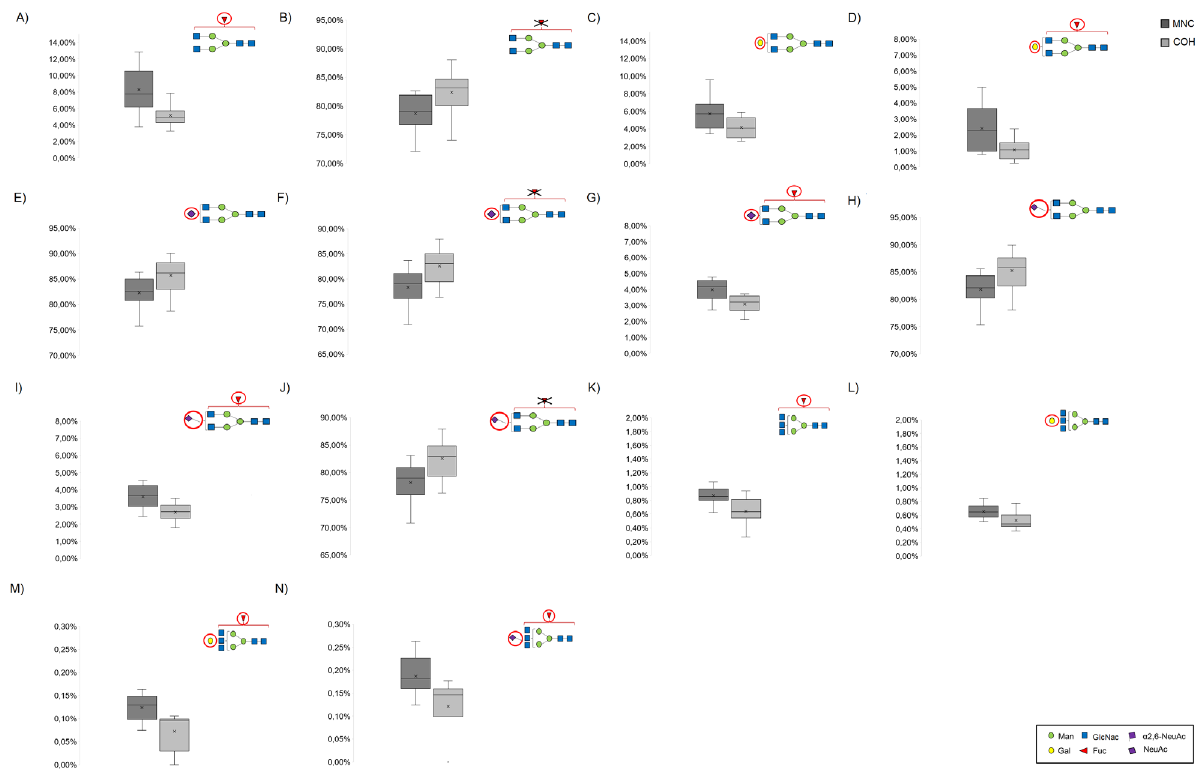
Figure 5: Statistically significant (Mann-Whitney U test, p<0,05) deregulated FFNGs-derived traits presented as mean ±SD between MNC and COH groups of patients. The presented traits are exclusively FFNGs additional traits derived from (A-J) diantennary and (K-N) triantennary complex type N-glycans identified in both analyzed groups. The displayed traits include: (A) % of fucosylated diantennary compositions; (B) % of afucosylated diantennary compositions; (C) % of galactosylation diantennary compositions; (D) % of galactosylation of fucosylated compositions; (E) % of sialylation of diantennary compositions; (F) % of sialylation of afucosylated diantennary compositions; (F) % of sialylation of afucosylated diantennary compositions; (G) % of sialylation of fucosylated diantennary compositions; (H) % of ɑ2,6- sialylation of diantennary compositions; (I) % of ɑ2,6- sialylation of fucosylated diantennary compositions; (J) % of ɑ2,6- sialylation of afucosylated diantennary compositions; (K) % of fucosylated triantennary compositions; (L) % of galactosylation of triantennary compositions; (M) % of galactosylation of fucosylated triantennary compositions and (N) % of ɑ2,6- sialylation of fucosylated triantennary compositions. The minimal N-glycan structure representing each trait is presented in each panel with a red circle that indicates analyzed features. Abbreviations: Man, mannose; Gal, galactose; Fuc, fucose; HexNac, N-Acetylhexosamine; NeuAc, sialic acid; α 2,6- NeuAc, α 2,6 –linked sialic